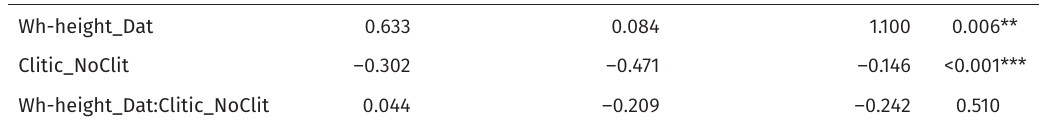
Table 4: Study 2 – Generalized linear mixed model fitted by using Markov chain Monte Carlo techniques (Hadfield 2010) with ordinal